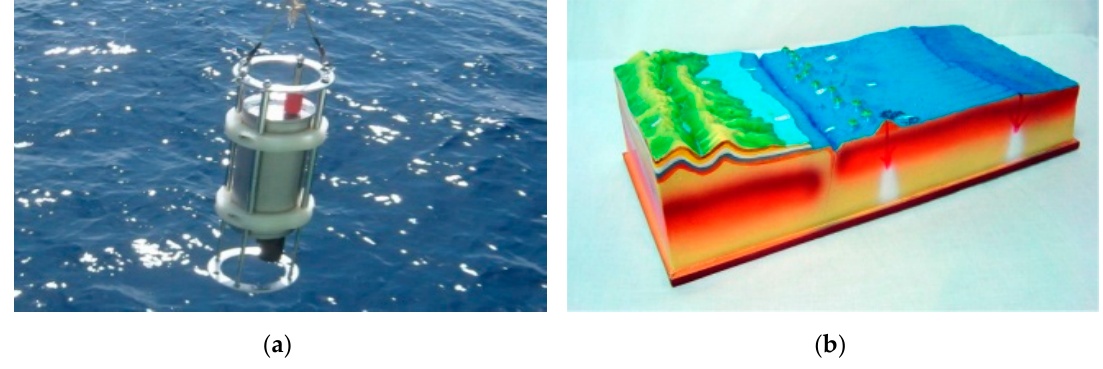
Figure 1. ( a ) On-site measurement, ( b ) Geoacoustic parameters inversion.